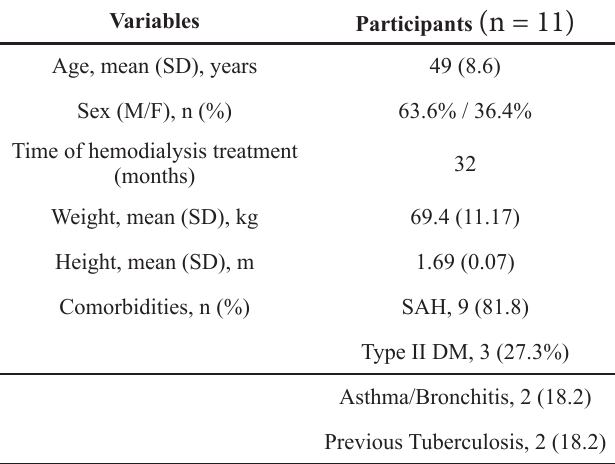
TABLE 2 - Characteristics of the participants with Chronic Renal Failure on